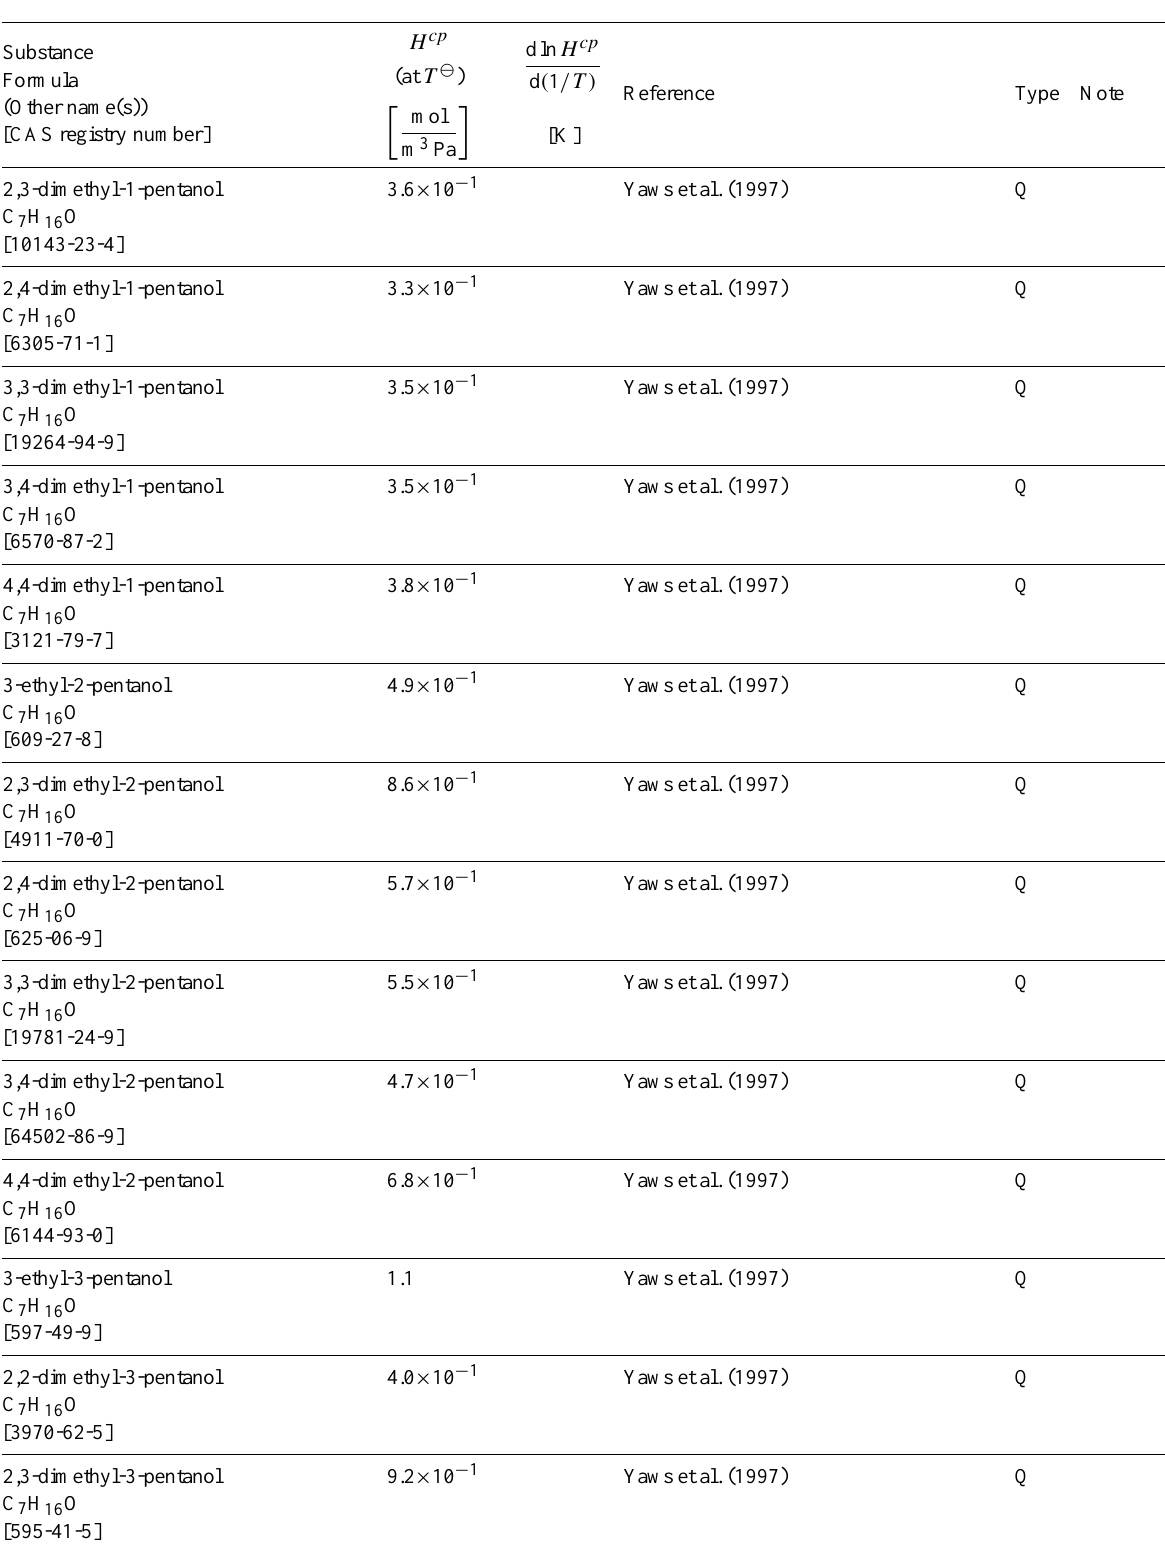
Table 6: Henry’s law constants for water as solvent